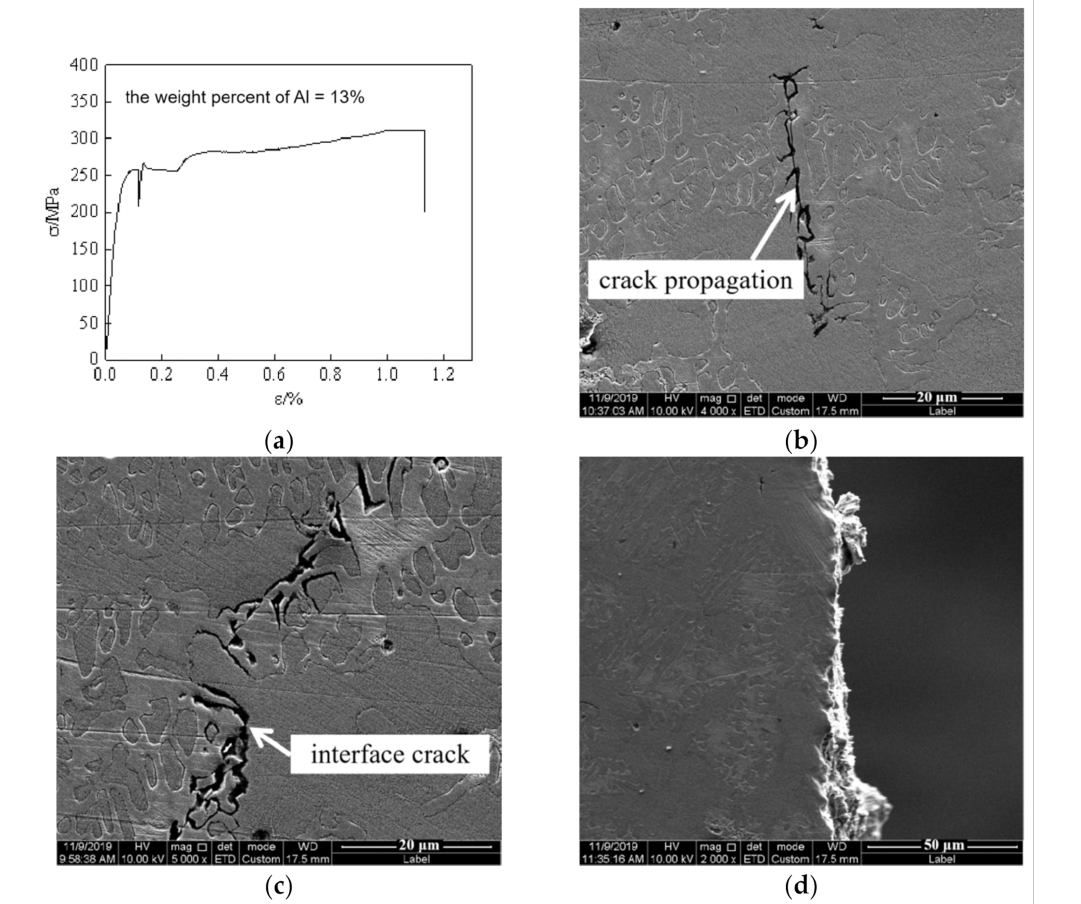
Figure 11. Crack evolution process of Fe-25Mn-13Al-8Ni-C alloy, ( a ) stress–strain curve; ( b ) ε = 0.1%, σ = 256.1 MPa, 4000 × ; ( c ) ε = 1.1%, σ = 310.8 MPa, 5000 × ; ( d ) ε = 1.1%, σ = 310.8 MPa, 2000 ×